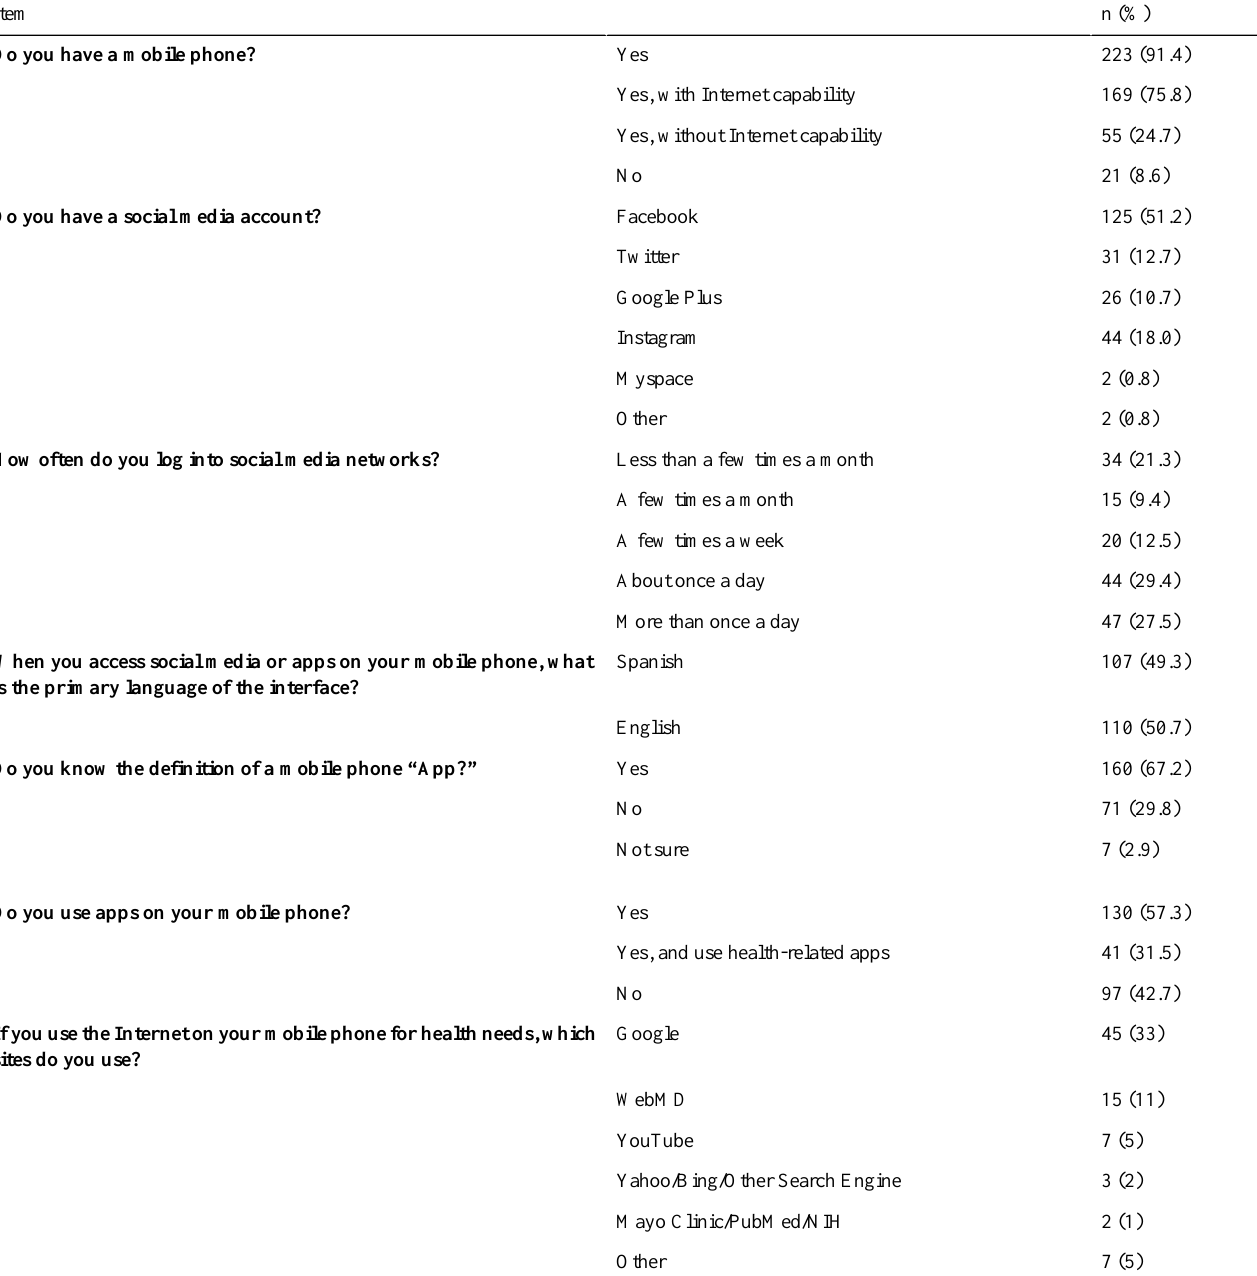
Table 2. Mobile phone/Internet